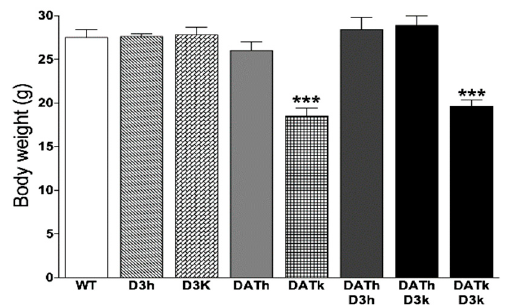
Figure 1. Bodyweight of wild type, dopamine transporter (DAT), and D3 single mutants and DAT/D3 double mutants. Values represented in mean ± S.E.M in grams of body weight. *** p < 0.001 vs. wild type (WT) controls.